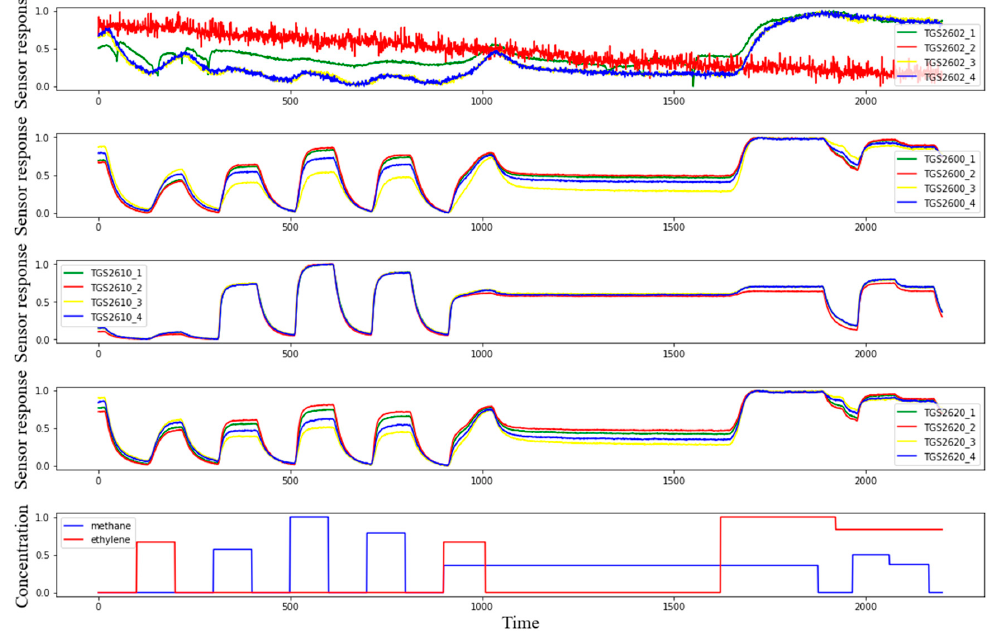
Figure 3. The sensor responses and gas concentrations.